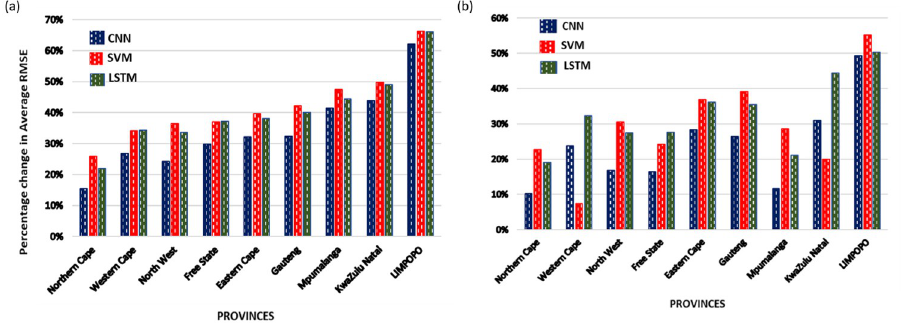
Fig 6. Percentage change in performance of each ML method for predictions in Experiment II. (a) & (b): Percentage change in performance of each ML method over each province when predictions were made with the (a) upward augmented data-set and (b) downward augmented data-set instead of the real-world data. High percentage RMSE indicates an improvement in performance and vice-versa.